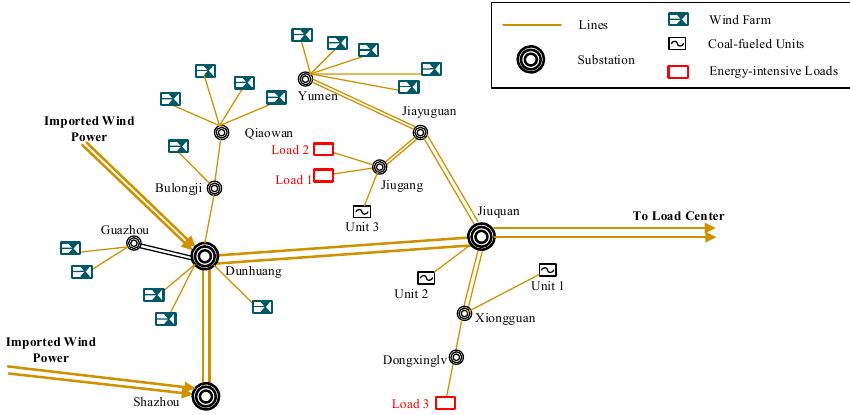
Figure 5. The simplified diagram of the target system.